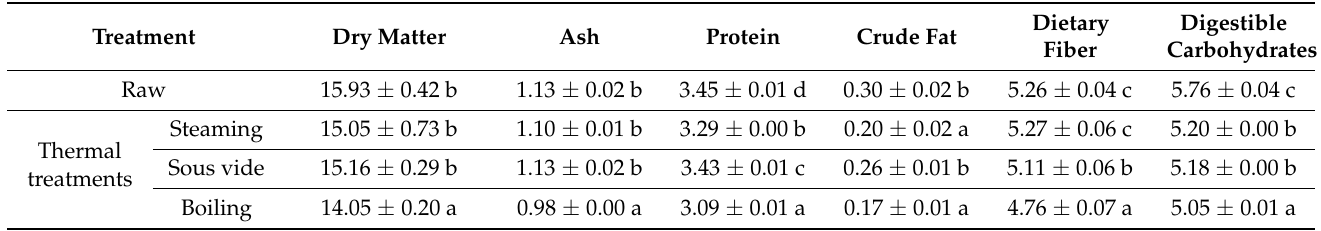
Table 1. Dry matter content and the chemical composition of Brussels sprouts raw and after thermal treatments (g/100 g